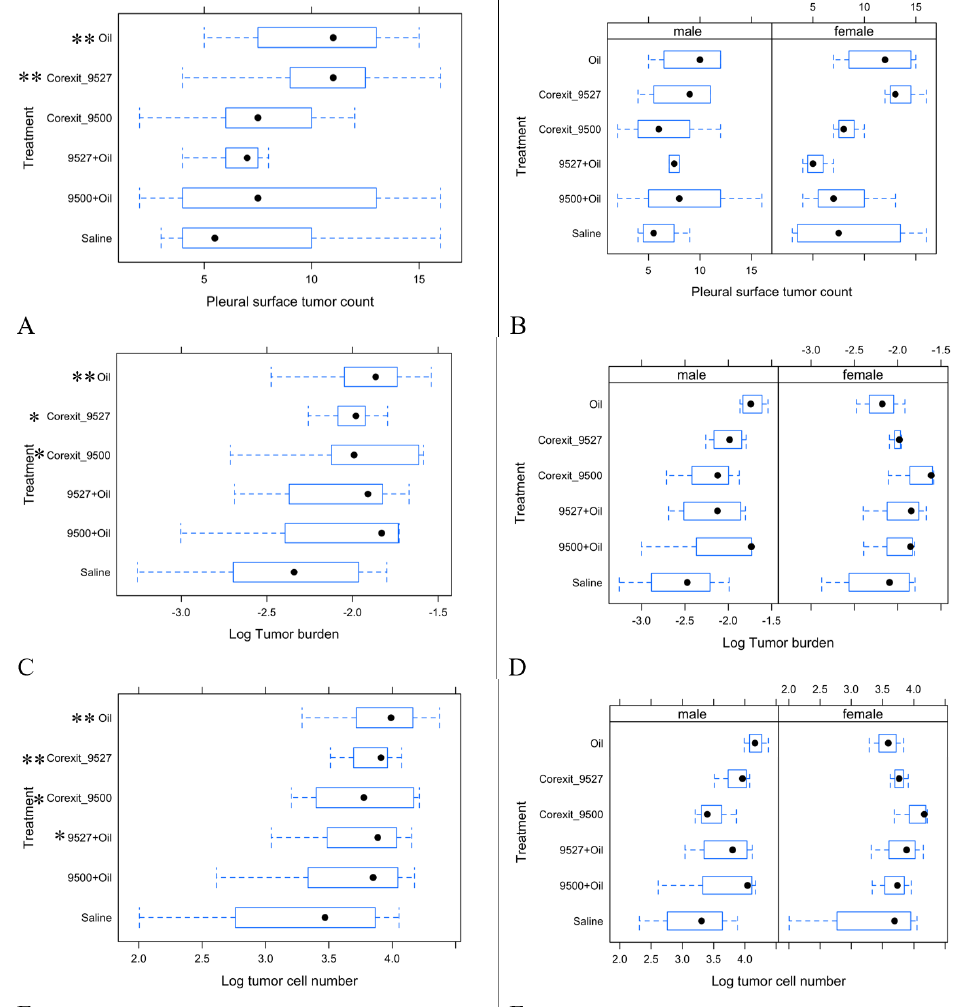
Figure 4. Box plots of K-Ras LA1 mice lung tumor indices across di ff erent treatments. ( A ) Box plot for the pleural surface tumor count for each treatment with combined sexes; ( B ) Box plot for pleural surface tumor count for each treatment and sex; ( C ) Box plot for tumor burden (log transformed) for each treatment for combined sexes; ( D ) Box plot for tumor burden (log transformed) for each treatment and sex; ( E ) Box plot for tumor cell number (log transformed) for each treatment for combined sexes; ( F ) Box plot for tumor cell number (log transformed) for each treatment and sex. Additionally shown in A, C and E are those groups whose lung tumor indices are significantly ( p < 0.05, indicated by **) or marginally significantly ( p < 0.10, indicated by *) elevated compared with saline control.